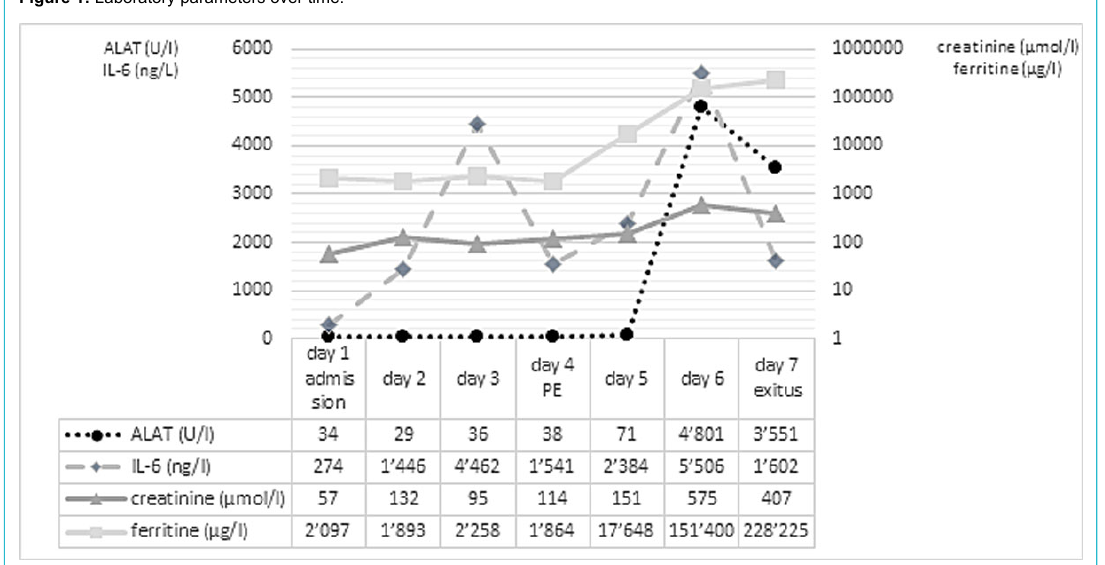
Figure 1: Laboratory parameters over